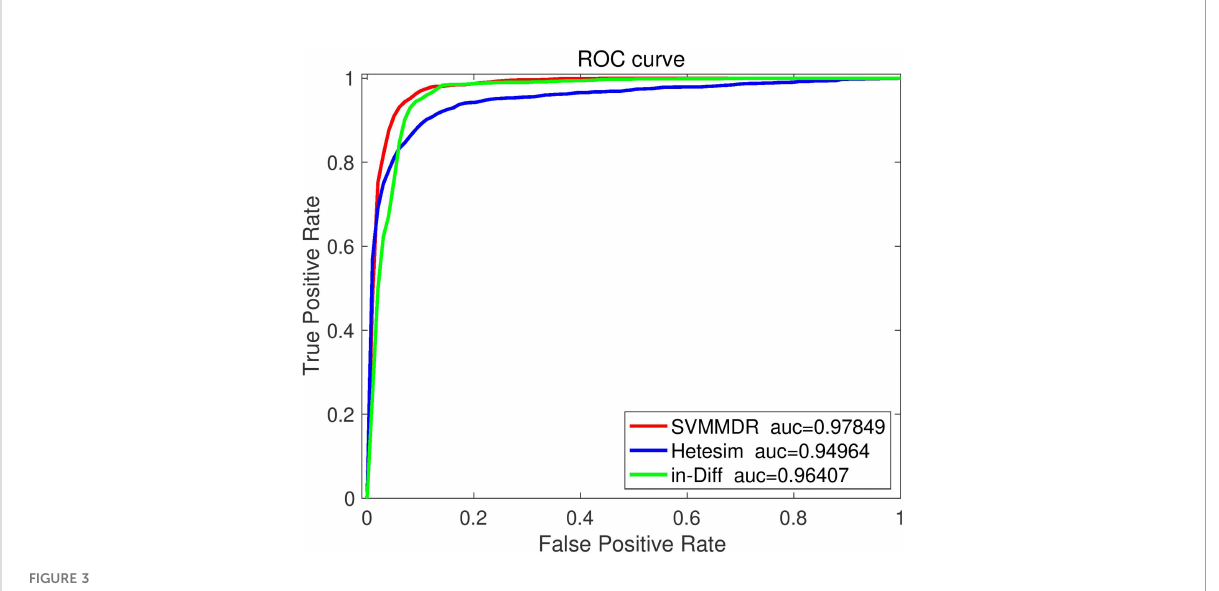
FIGURE 3 The ROC curve comparison with different